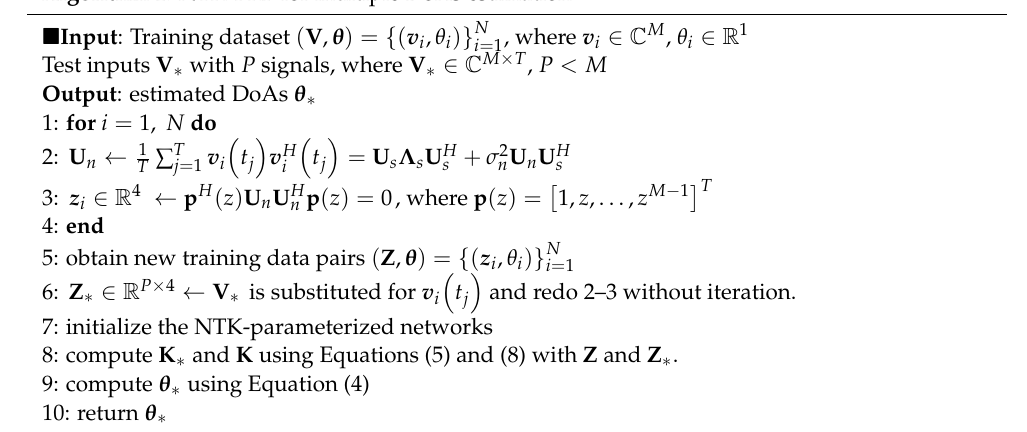
Algorithm 1 : NTK-PRF for multiple DoAs